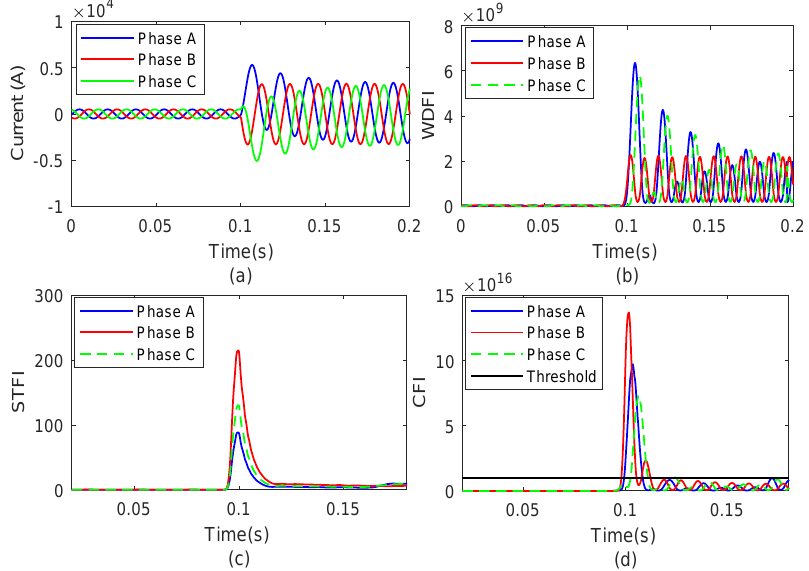
Figure 8. Detection of fault involving all the phases and ground ( a ) current waveform ( b ) WDFI ( c ) STFI ( d )